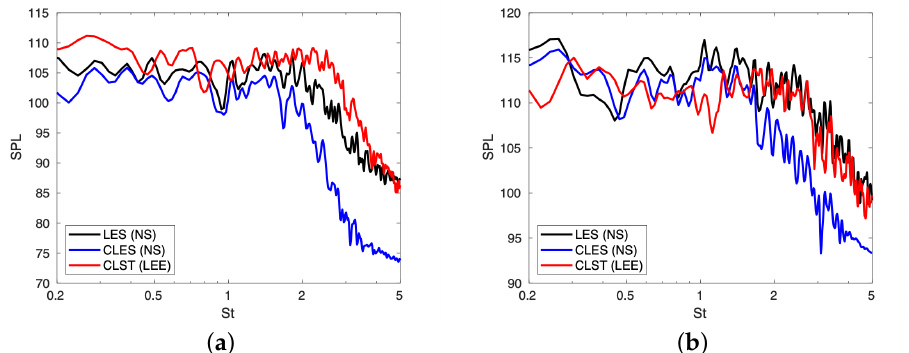
Figure 12. SPL Spectra for CLST along the Line y = 7.5D j : ( a ) Point P5 (x = 0D j ). ( b ) Point P6 (x = 10D j